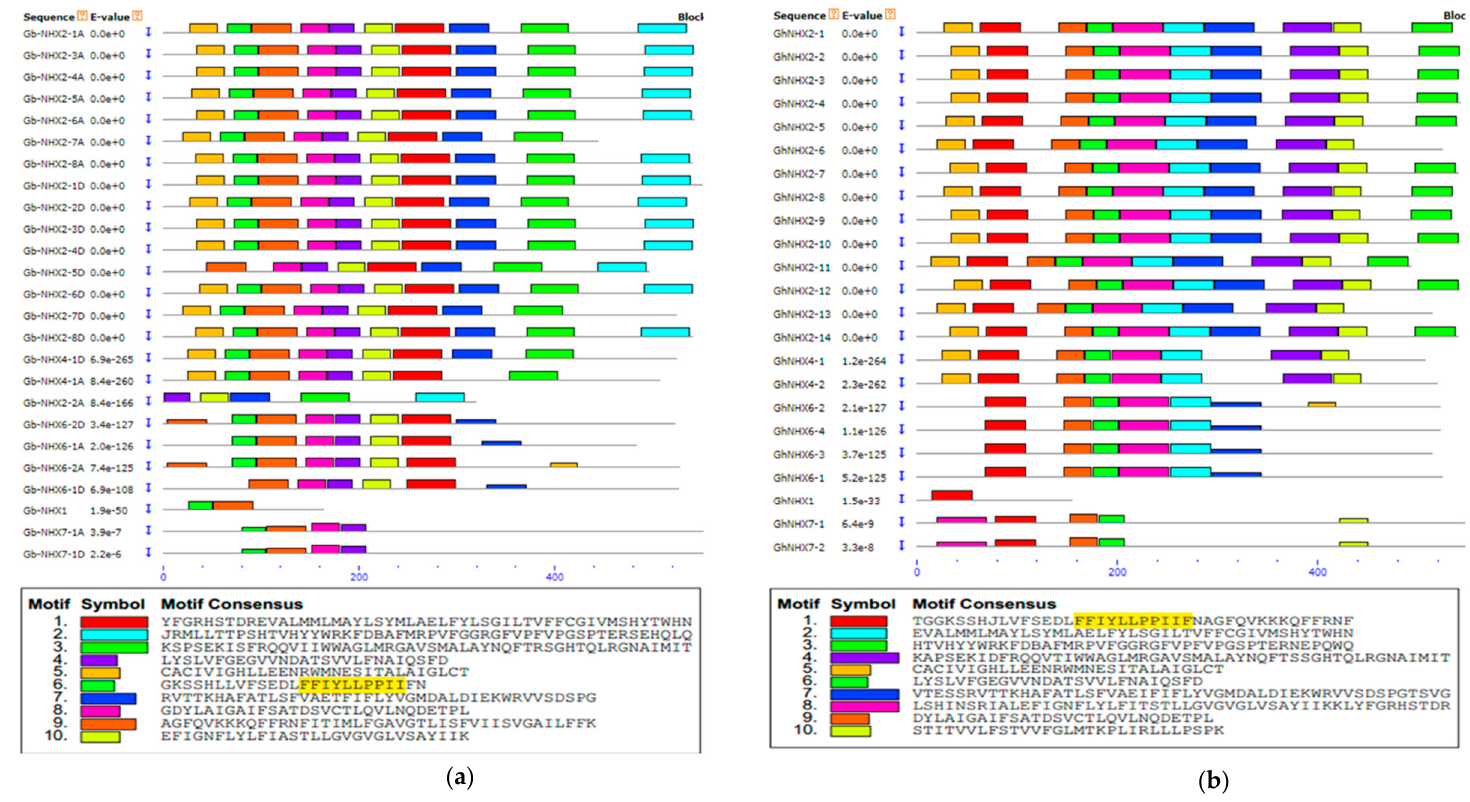
Figure 3. Conserved motif analysis of the NHX genes. ( a ) Motifs of the GbNHX Amiloride binding site) are represented by motif 7. ( b ) Motifs of the GhNHX Amiloride binding site are shown by motif 1. The sequence for amiloride binding site ((L/F)FF(I/L)(Y/F)LLPPI is highlighted.